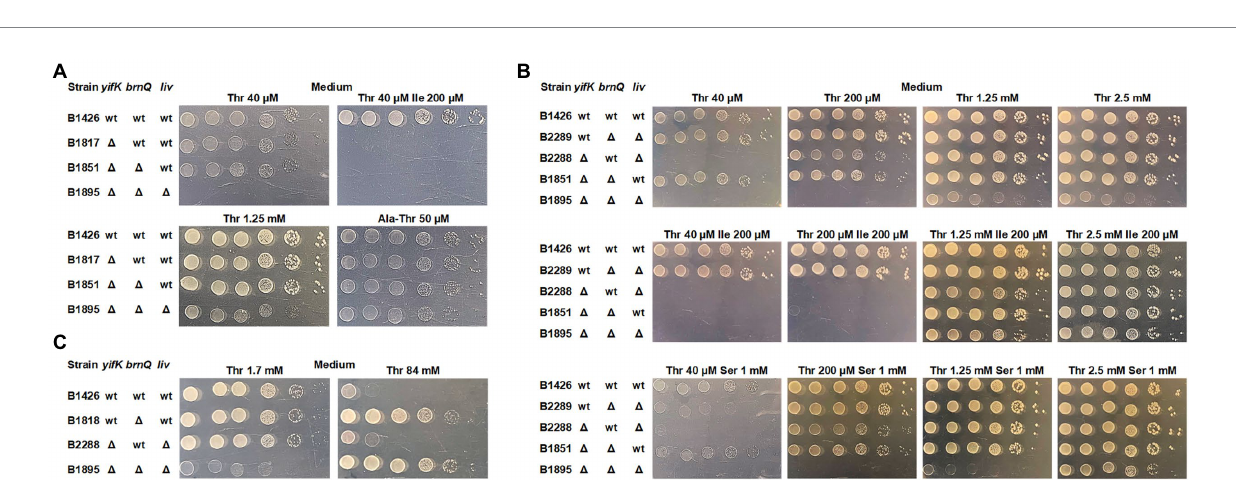
FIGURE 2 Phenotype assay of the threonine-auxotrophic B1426 strain and its derivatives carrying deletions of genes controlling threonine uptake. The assay was performed using M9 minimal medium with 0.2% glucose and the indicated additives as described under “Phenotype assay” in the Materials and Methods. “Thr,” “Ile,” “Ser,” and “Ala-Thr” abbreviations stand for L-threonine, L-isoleucine, L-serine, and L-alanyl-L-threonine, respectively. (A) Growth assay of the B1426 strain and its single, double, and triple mutant derivatives lacking the YifK, BrnQ, and LIV-I systems on minimal plates with either L-threonine or L-alanyl-L-threonine as the L-threonine source. (B) Growth assay of the B1426 strain and its double mutant derivatives possessing YifK, BrnQ, and LIV-I as the sole threonine transport system at gradually increasing L-threonine concentrations. L-isoleucine and L-serine were added